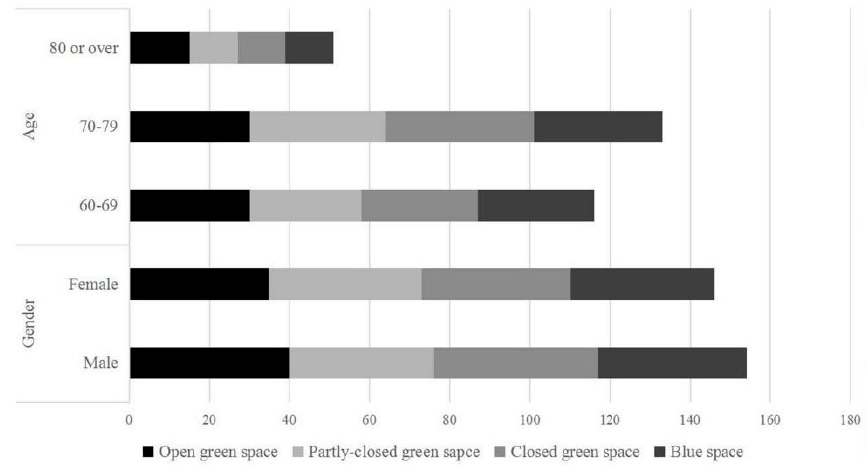
Figure 2. Demographic characteristics of the respondents.